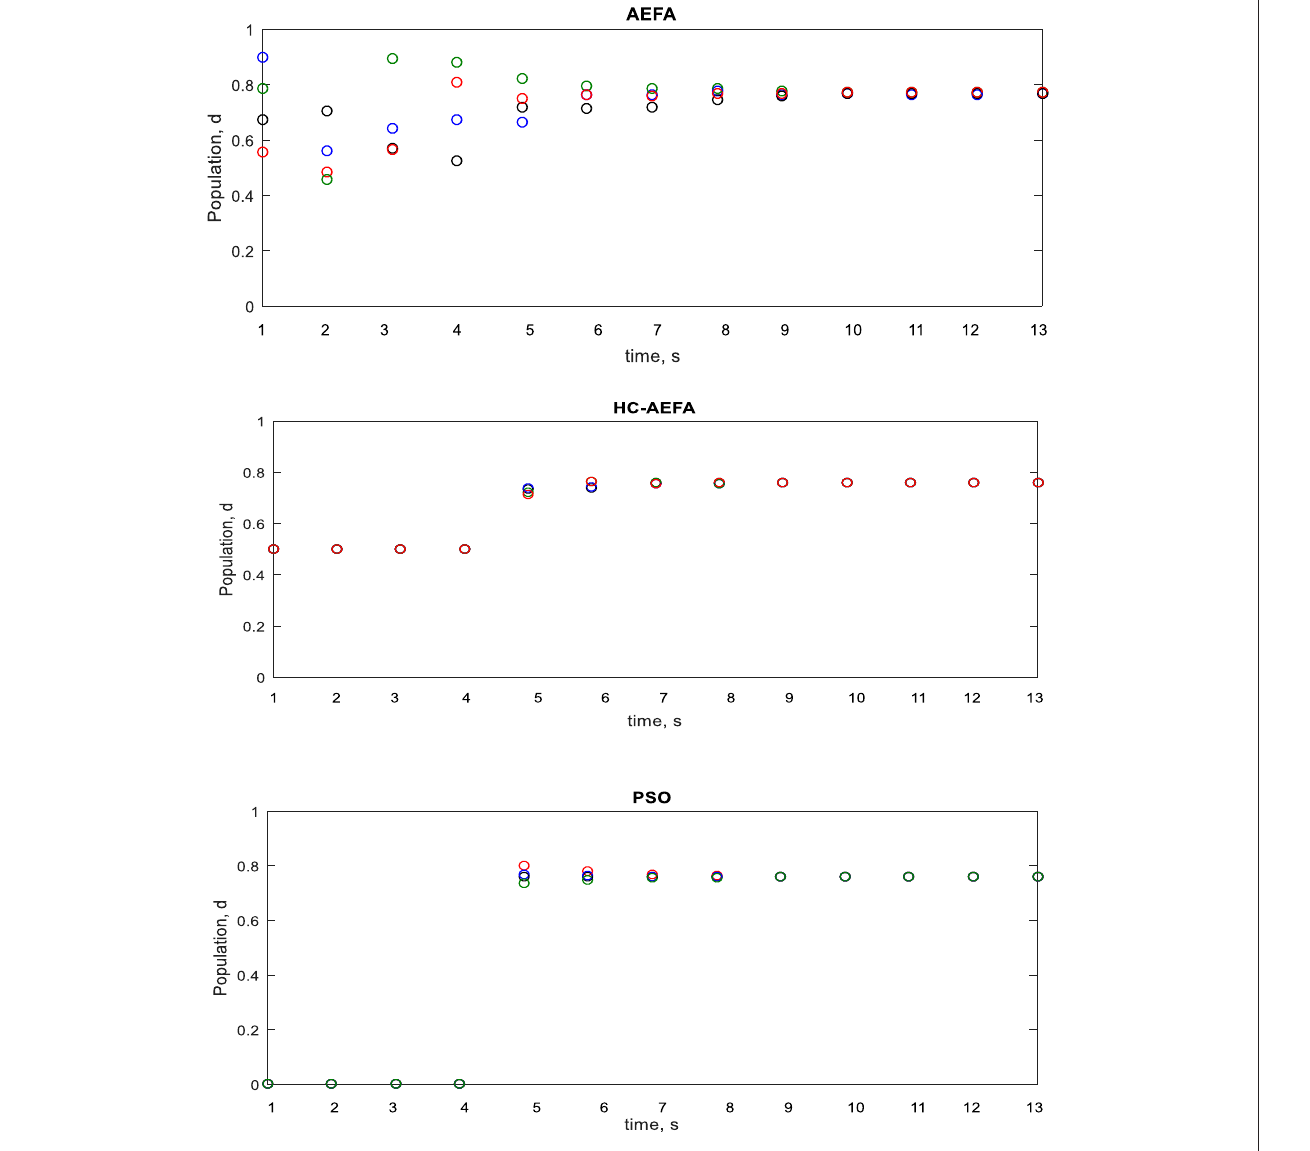
TABLE 4 | Results for the different MPPT methods in third pattern.